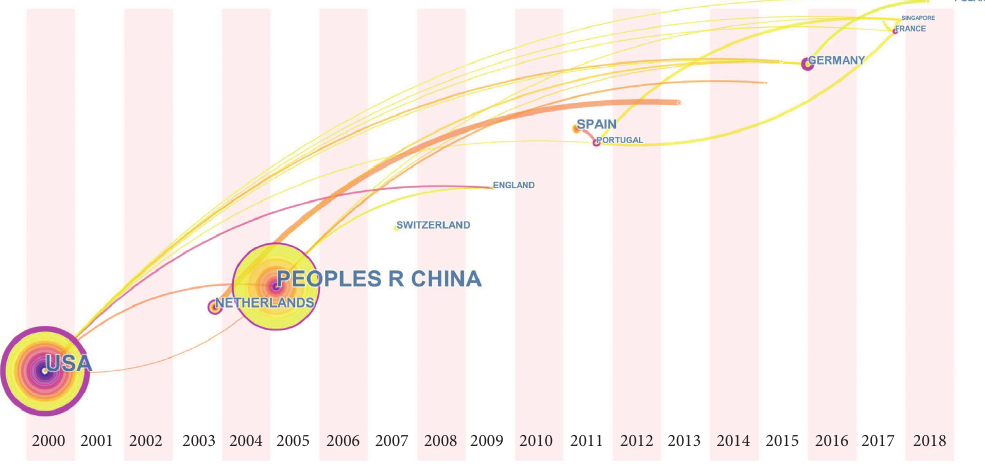
Figure 2: Timeline view on country cooperation.